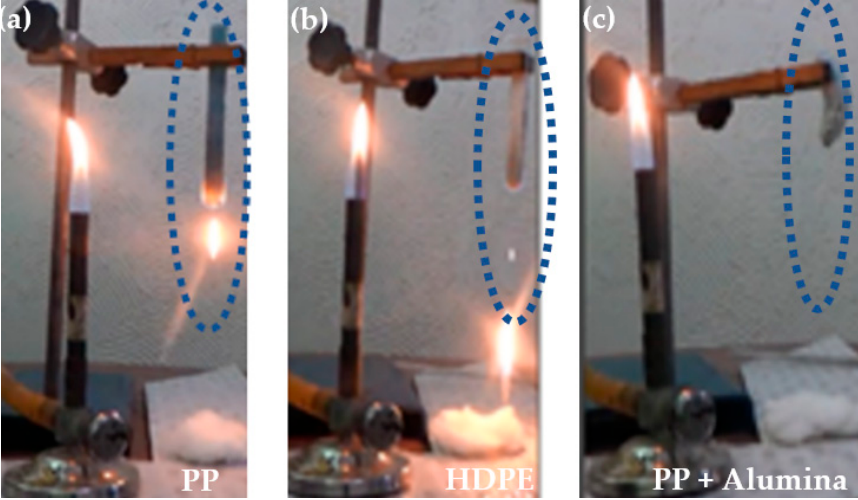
Figure 9. Flammability test after 10 seconds removal from the flame: ( a ) PP; ( b ) HDPE; ( c ) PP + 5% alumina.